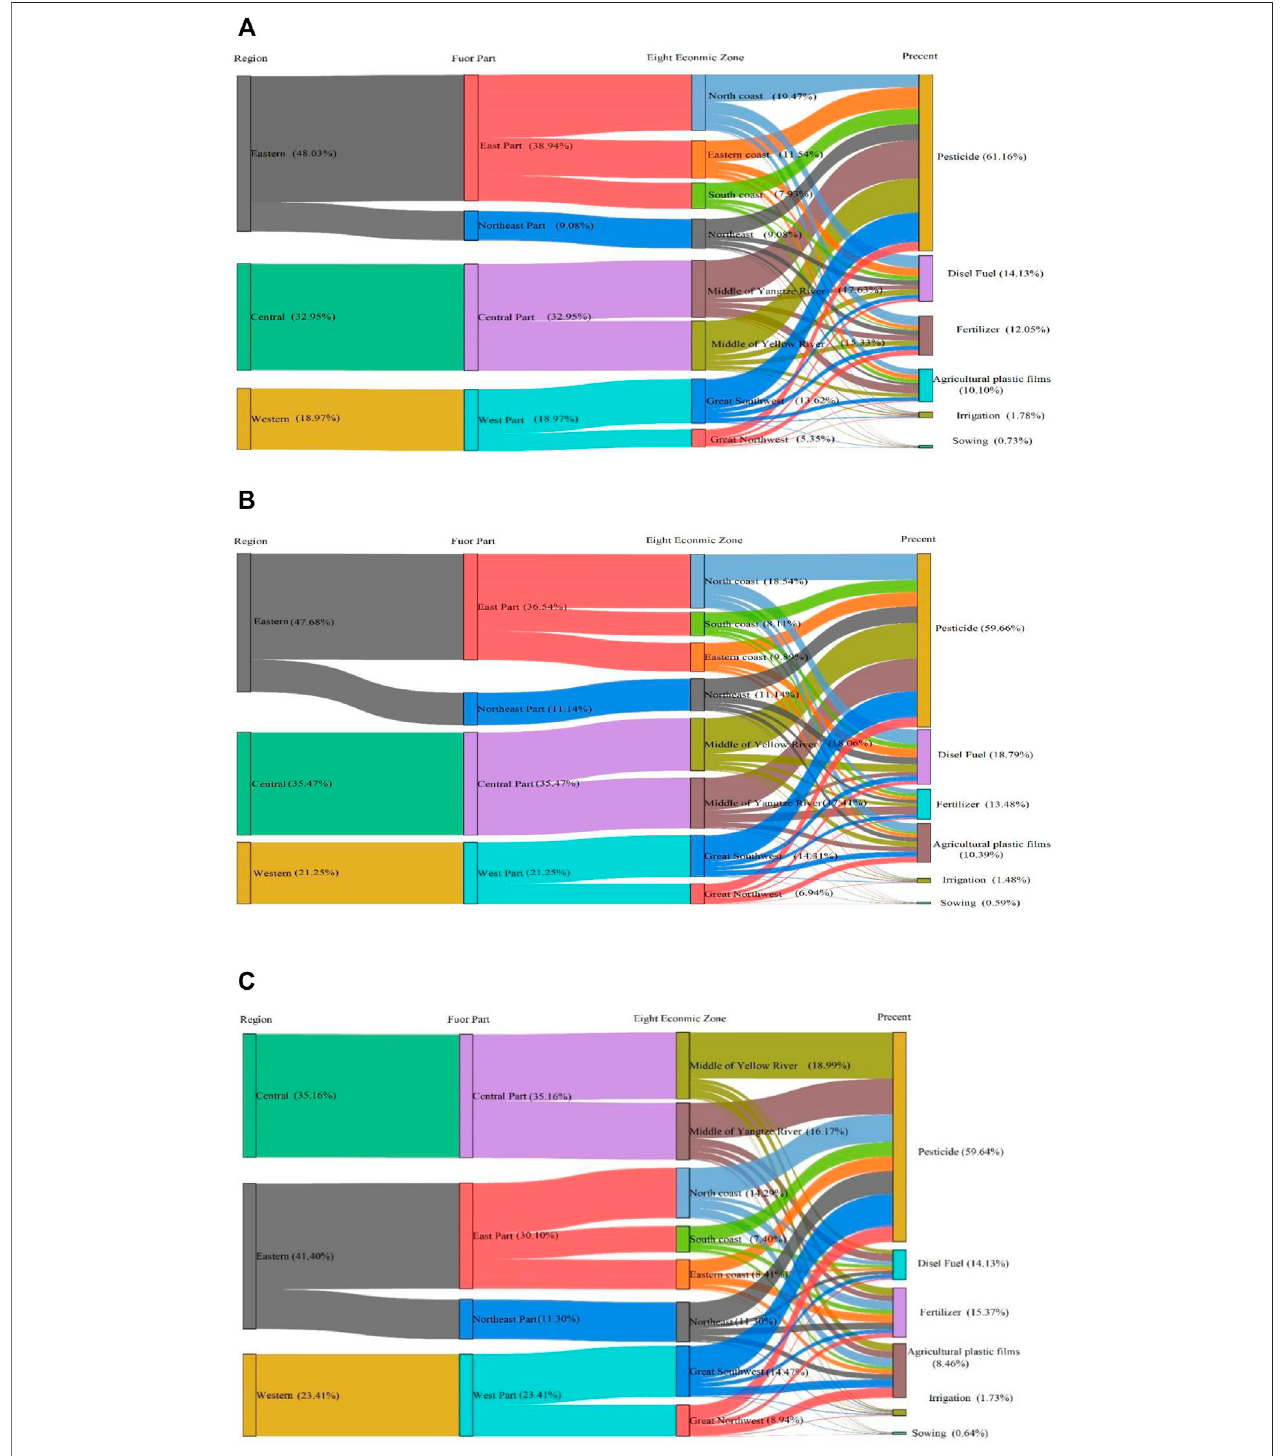
FIGURE 3 | Agricultural Carbon Emission Flow from 2001 – 2019 [ (A) : 2001, (B) : 2010, (C) : 2019].